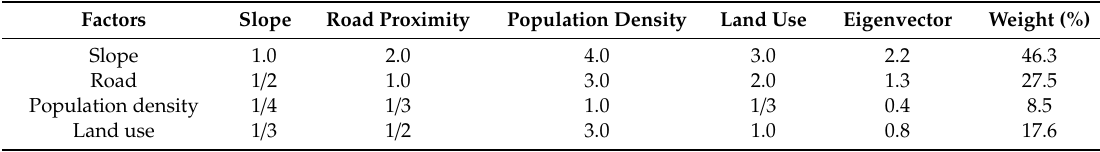
Table 2. Pairwise matrix for calculation of the weight of factors.